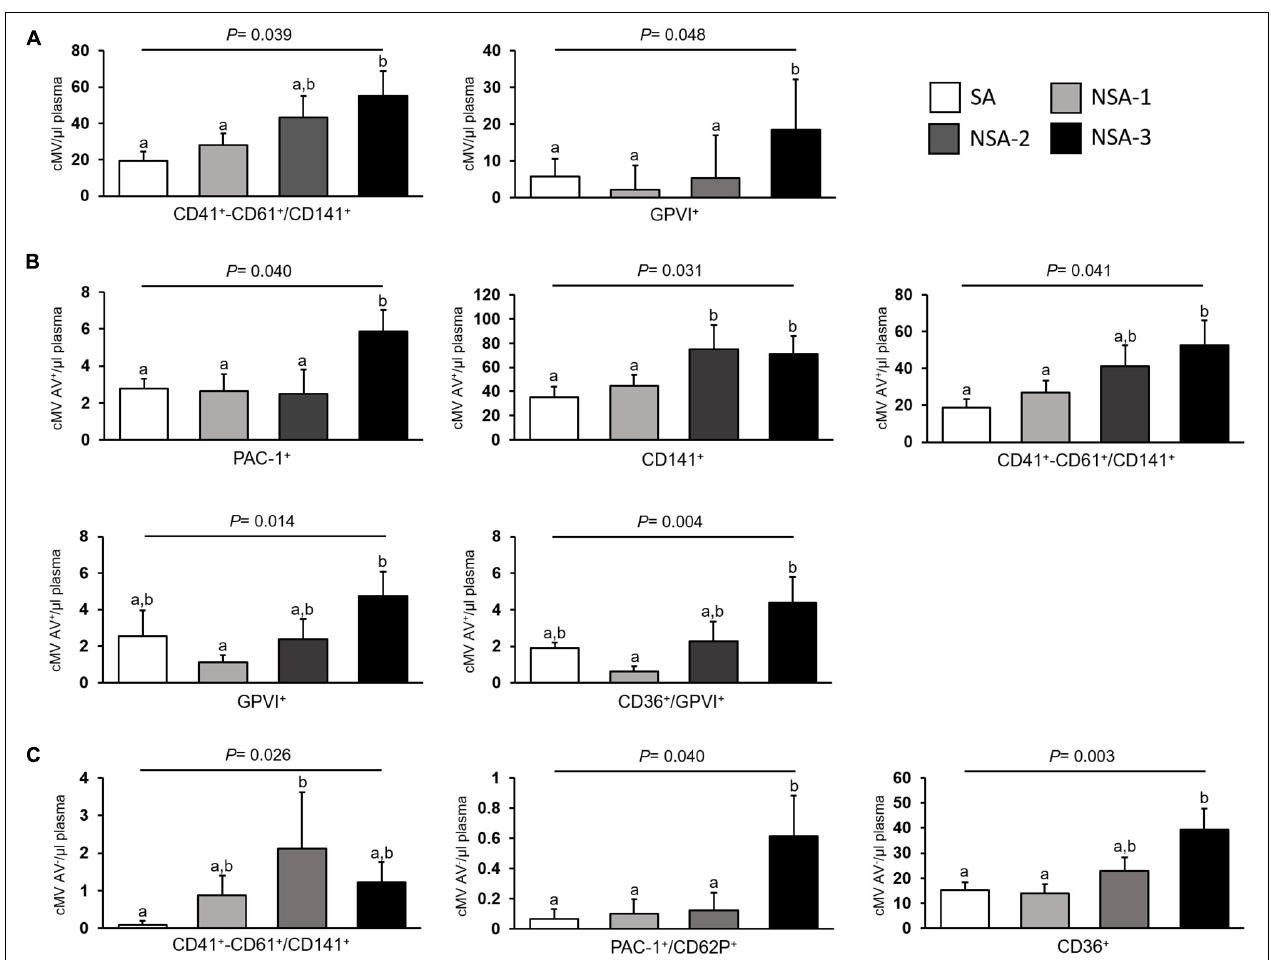
FIGURE 1 | cMV levels according to successful aging in the 135 octogenarians included in the study. Results are shown as mean + SEM of concentrations of: (A) total microvesicles; (B) AV + microvesicles; and (C) AV − microvesicles. Successful aging ( n = 48) was defined as good functional (Barthel Index > 90 points, and Lawton Index scores > 7 for women and > 4 men) and cognitive status (MEC > 24 points), and no need for institutionalization. Non-successful aging (NSA, n = 87) was further categorized in having one (NSA-1, n = 28), two (NSA-2, n = 23), or three scores (NSA-3, n = 36) below good functional and/or cognitive status (Barthel Index ≤ 90 points, Lawton Index scores ≤ 7 for women and ≤ 4 men, and/or MEC ≤ 24 points). AV indicates annexin V and cMV, circulating microvesicles. Used markers for MV phenotyping are shown in Supplementary Table 1 . Columns with different superscript letters indicate significant differences (P < 0.05, Bonferroni post hoc